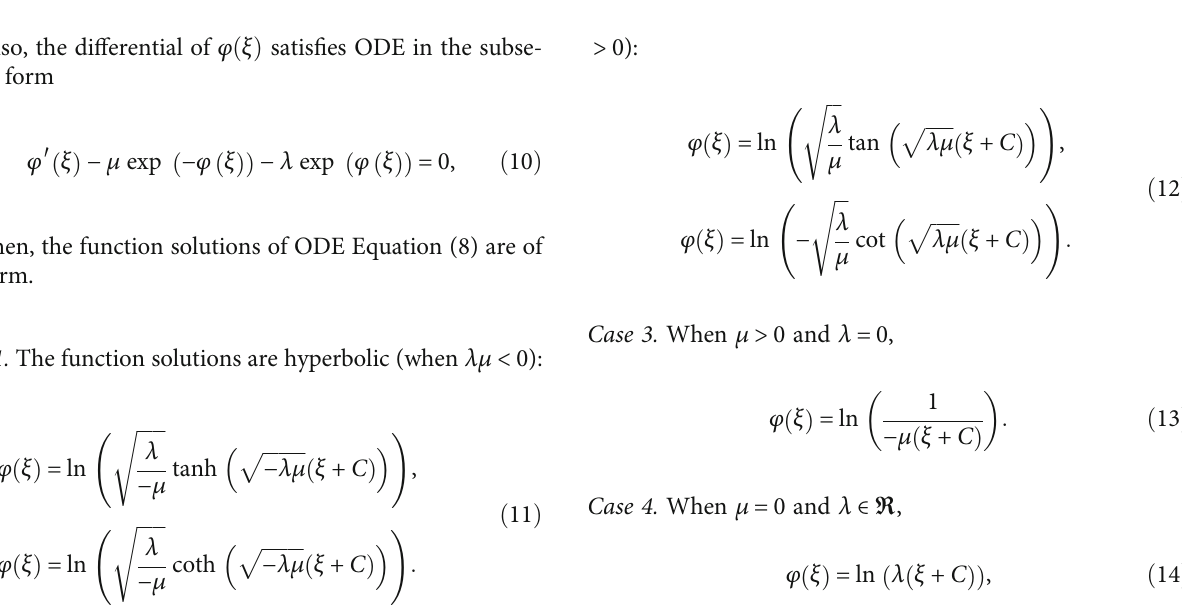
, t Þ . (a, b) 3D plot and (c) 2D combined plot for x = 1 6,7 ð x